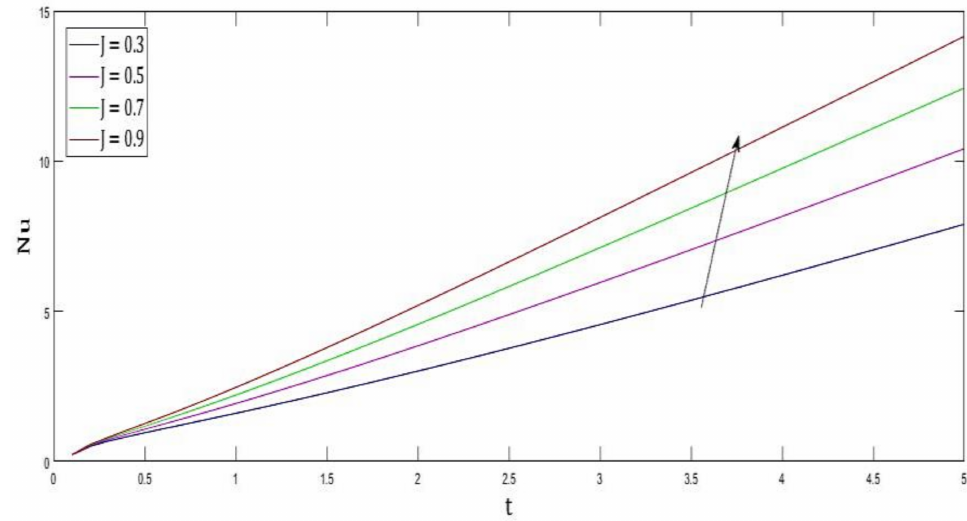
Figure 12. Variation in Nusselt number with respect to heat absorption